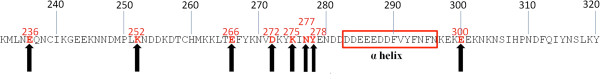
Full-length sequence of Plasmodium falciparum JR and the sequences of truncated pfJRTS mutants. The 89 amino acids of the full-length sequence of P. falciparum JR are shown, with amino acid numbers in relation to the full-length bifunctional pfDHFR-TS indicated above the sequence. Arrows indicate the amino acids corresponding to the first amino acid of the truncated pfJRTS constructs. The region where the α-helix is located is marked in the box.